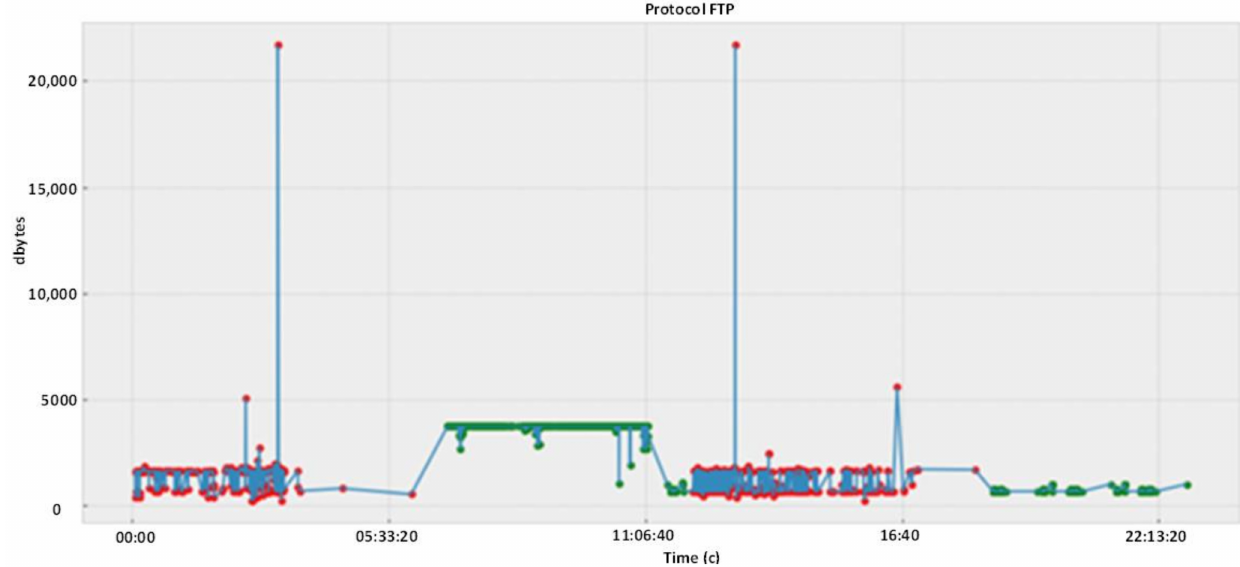
Figure 17. Implementation of the defense response against exposure to SG resources for the graph G (cid:48) = DDOS attack.